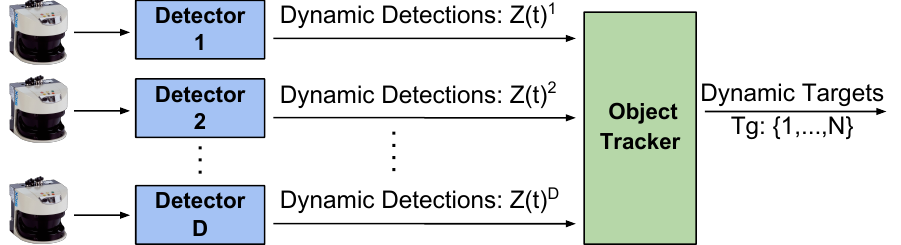
Figure 3. General DATMO proposed schema. Our system can now deal with several LRF sensors placed in the AGV. For each one, a moving object detector is instantiated having as only inputs the range measurements and the vehicle’s odometry. The MH-Tracker receives a list of dynamic objects from each of the detectors and tracks them through time, retrieving their speed, direction and status. Sections 3.1 and 3.2 detail respectively the internal processes performed by our detector and tracker